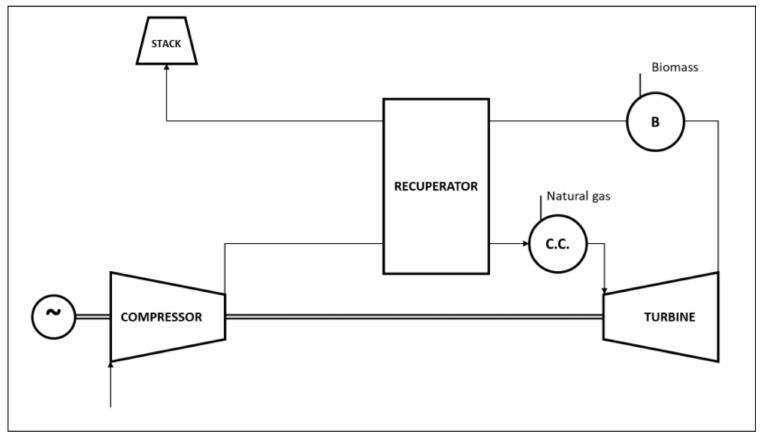
Figure 8. Dual Fuel micro Gas Turbine with both internal combustor and external furnace